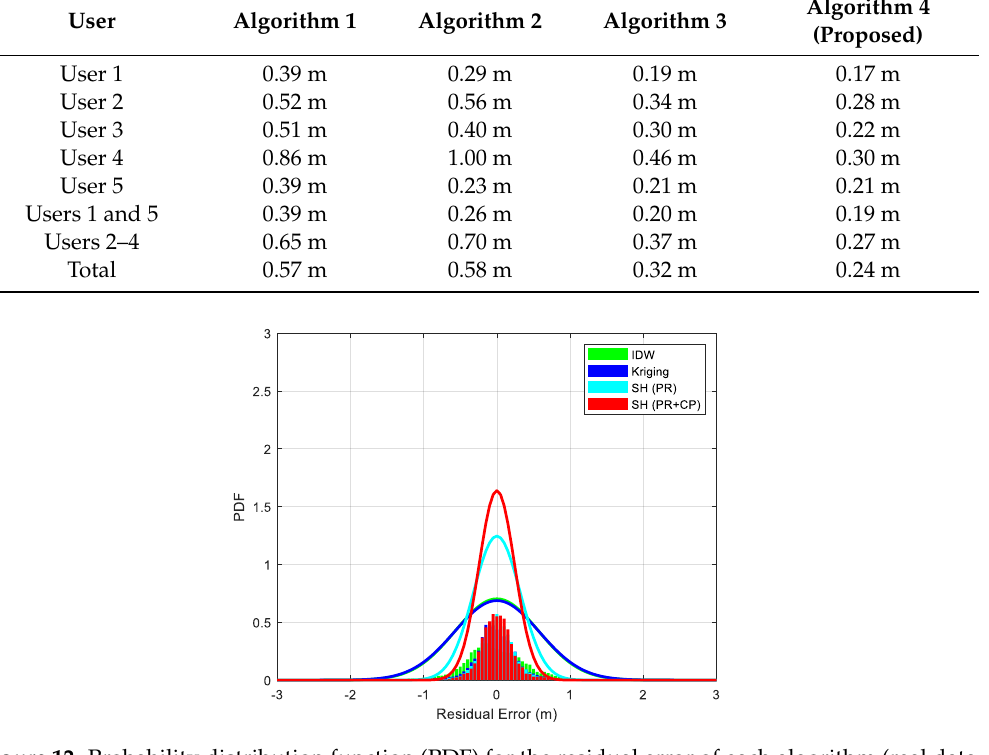
Figure 12. Probability distribution function (PDF) for the residual error of each algorithm (real data, 1 September 2014).